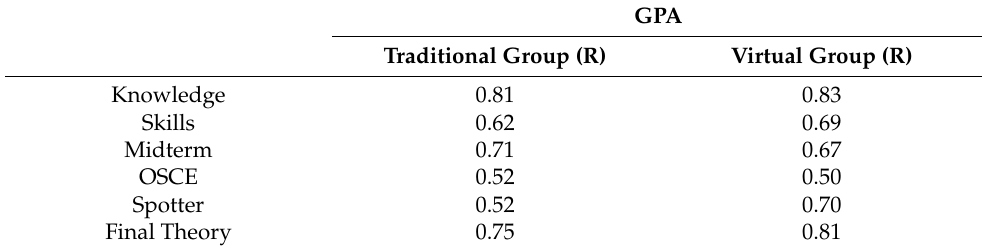
Table 5. Correlation of GPA and performance level between the